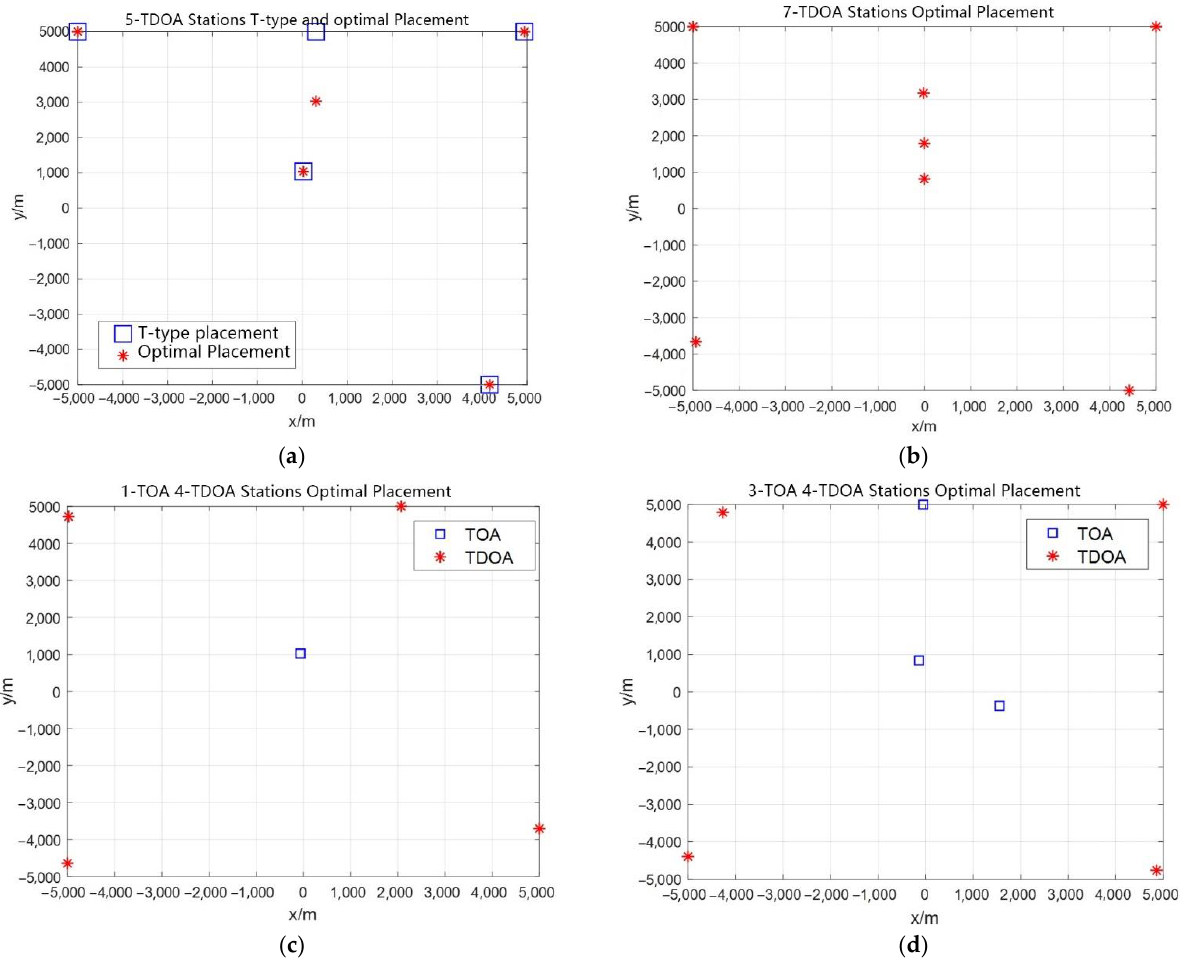
Figure 5. Optimal station placement results based on GA algorithm: ( a ) 5-TDOA stations T-type placement and optimized layout structure; ( b ) Optimized layout structure for 7-TDOA stations; ( c ) Optimized layout structure simulation for 1-TOA and 4-TDOA stations; ( d ) Optimized layout structure simulation for 3-TOA and 4-TDOA